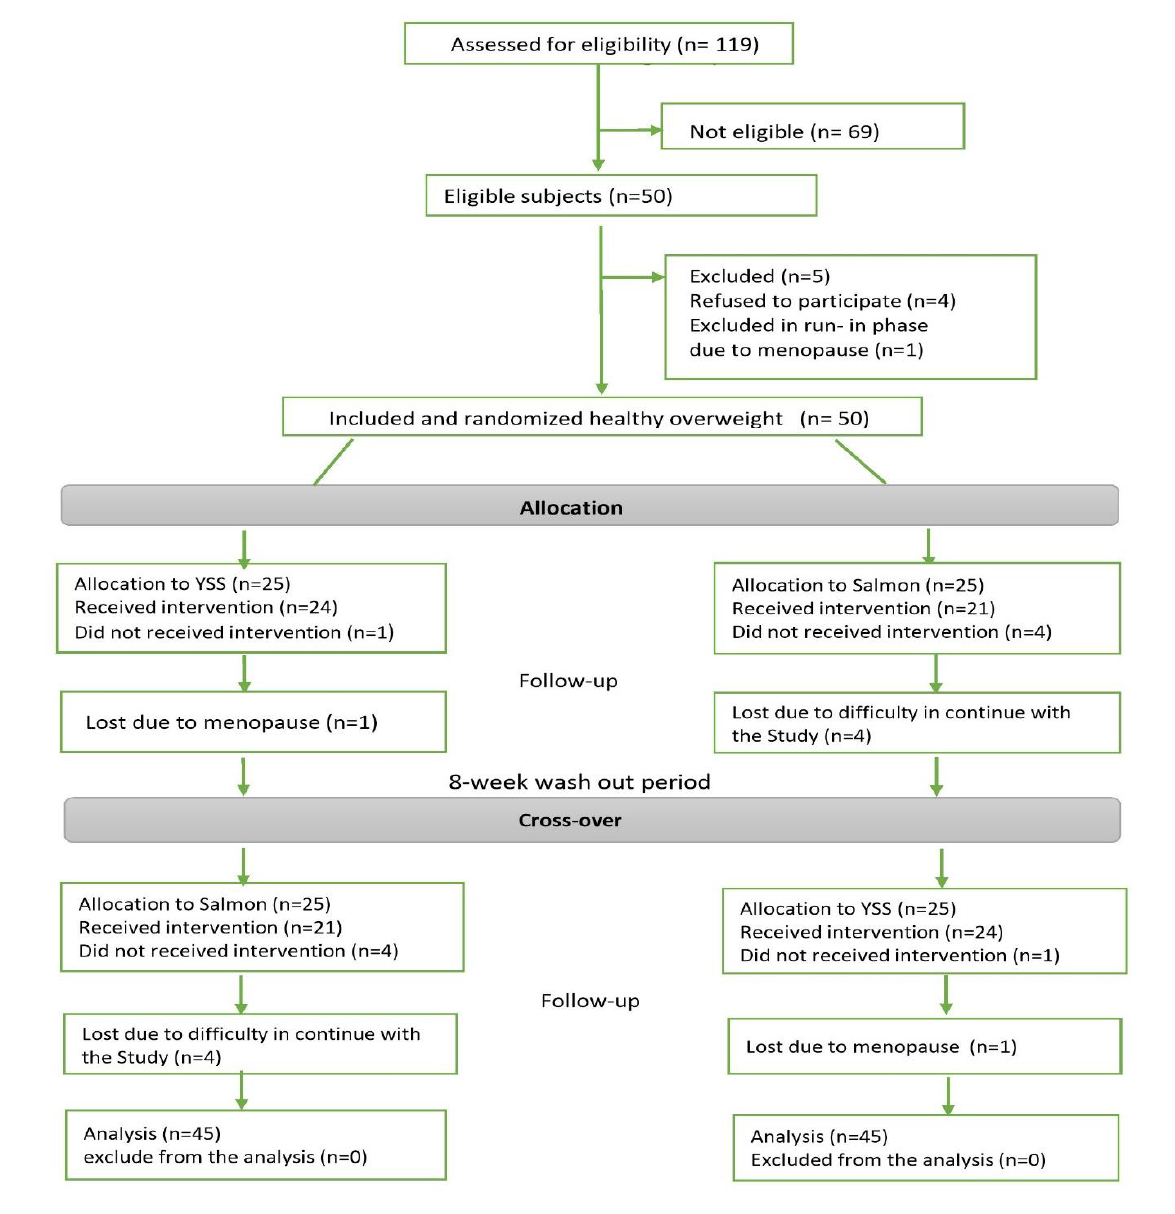
Figure 1: Phases of randomized